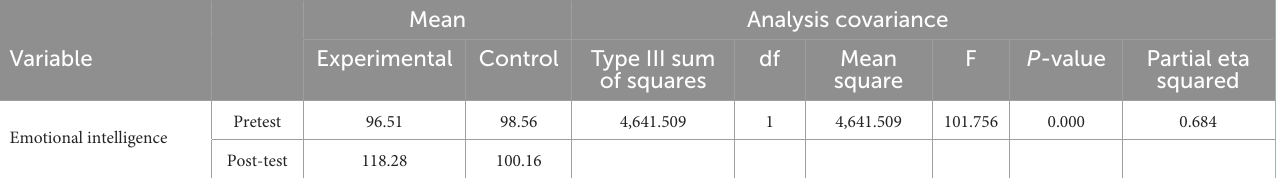
TABLE 6 Covariance analysis for emotional